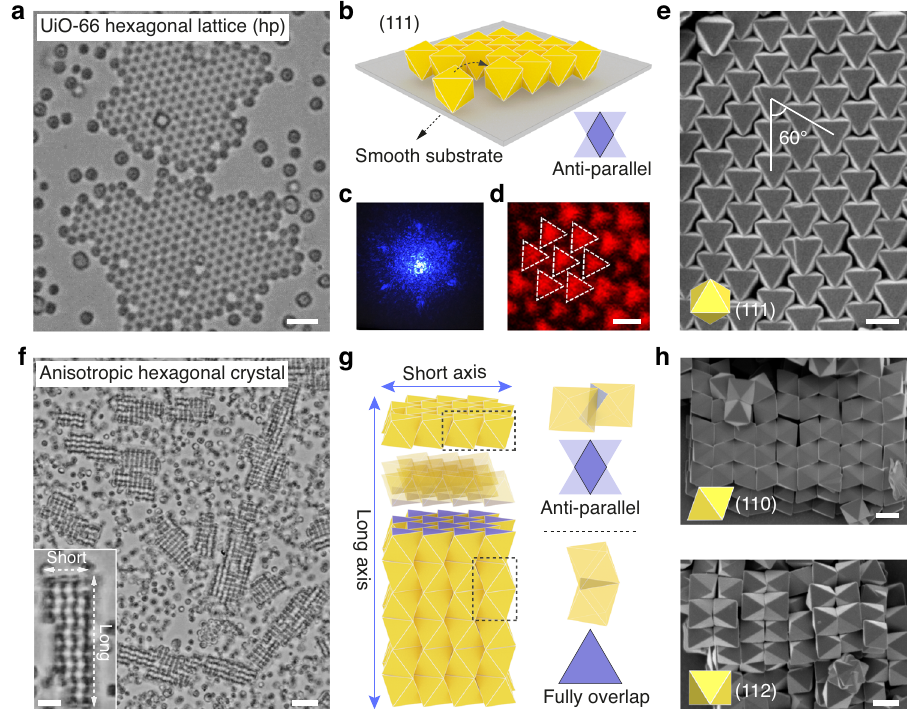
Fig. 4 Anisotropic and directional assembly of UiO-66 particles. a – e 2D hexagonal superlattice (hp) assembled on a smooth substrate. Optical microscope image of the UiO-66 fi lms is shown in ( a ). Cartoon in ( b ) shows particles sitting on the substrate by the triangular (111) face within the assemblies. They contact via their faces in an antiparallel fashion (shown in purple). Laser diffraction pattern of the resulting hexagonal lattice c . The (111) facet arrays are highlighted by re fl ected-light confocal microscopy ( d ) and SEM ( e ). f – h , Anisotropic quasi-1D stripe-like superstructure assembled from UiO-66 octahedra on a rough substrate. Optical image f shows the supercrystals; inset shows a crystal stripe and its long and short axes. Cartoons in ( g ) highlight the interparticle bonding within (along the short axis) and between hexagonal layers (along the long axis), featuring antiparallel (top right) and full facet overlap (bottom right), respectively. SEM images in ( h ) show the (110)- and (112)-oriented UiO-66 superstructures. Scale bars: 3 μ m ( a ), 1 μ m ( d , e , h ), 5 μ m ( f ), and 2 μ m ( f ,